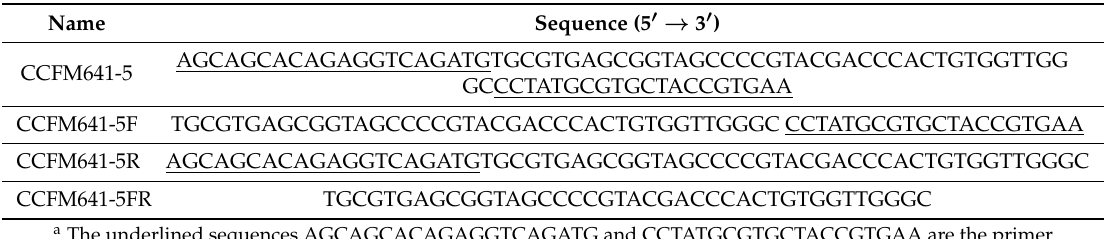
Table 2. Full-length aptamer CCFM641-5 and truncated aptamer variants a .